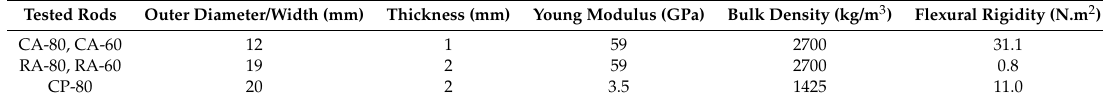
Table 1. Geometric and mechanical characteristics of the tested rods.